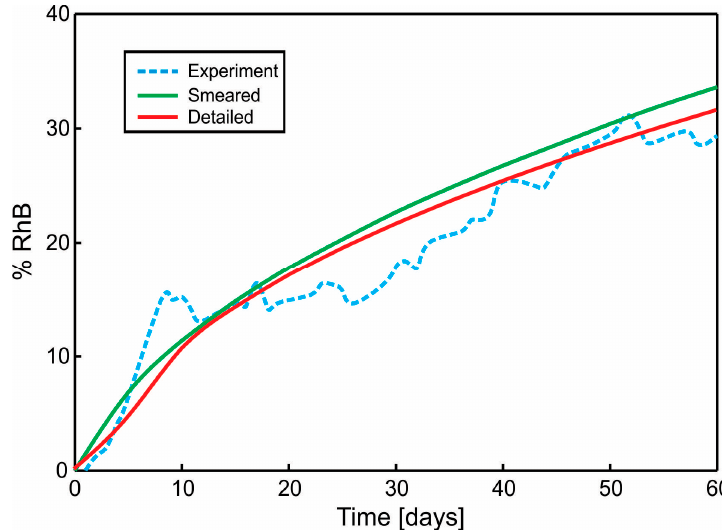
Figure 11. Cumulative Release vs. Time for Span-80/RhB complex impregnated and for 24 wt.% 65:35 PLGA. Experimental curve and computational results obtained using the true (detailed) and smeared model of PLGA nanofibers.